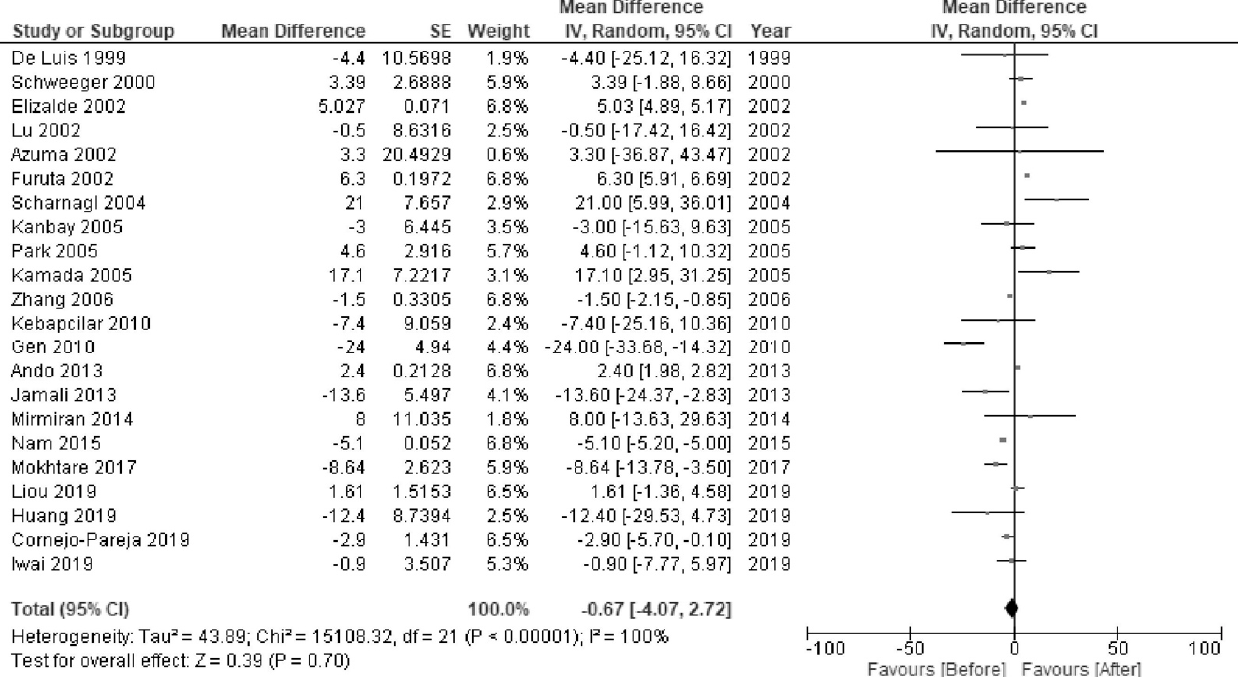
Figure 4. Forest plot of the mean changes in low-density lipoprotein cholesterol levels before and after Helicobacter pylori eradication.